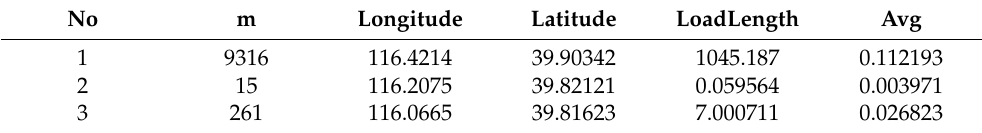
Table 17. The clustering results of the algorithm in this paper for the DS4 dataset.